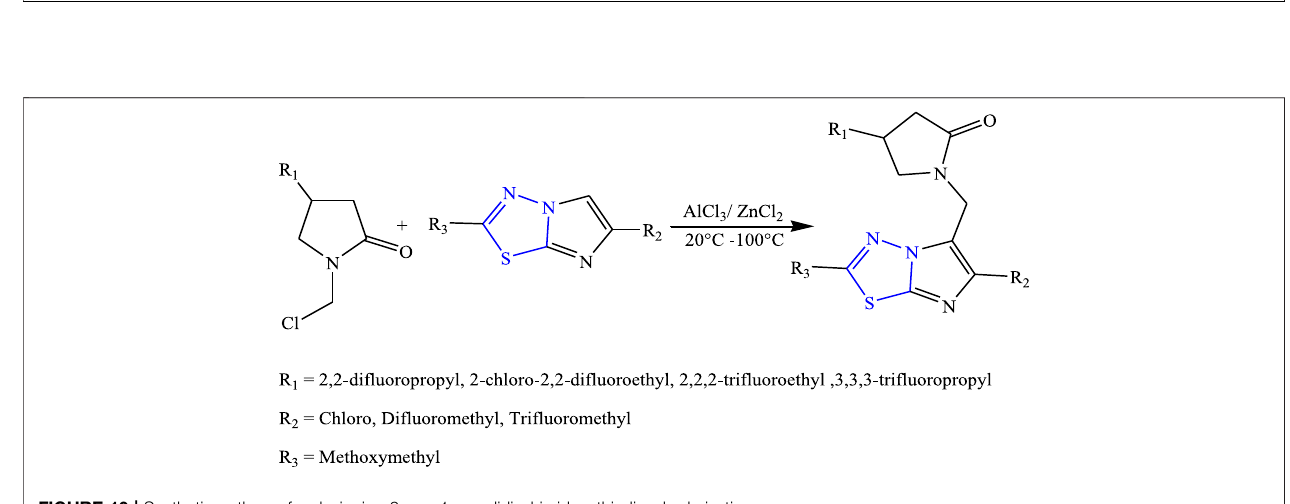
FIGURE 10 | Synthetic pathway for designing 2-oxo-1-pyrrolidinyl imidazothiadiazole derivatives.